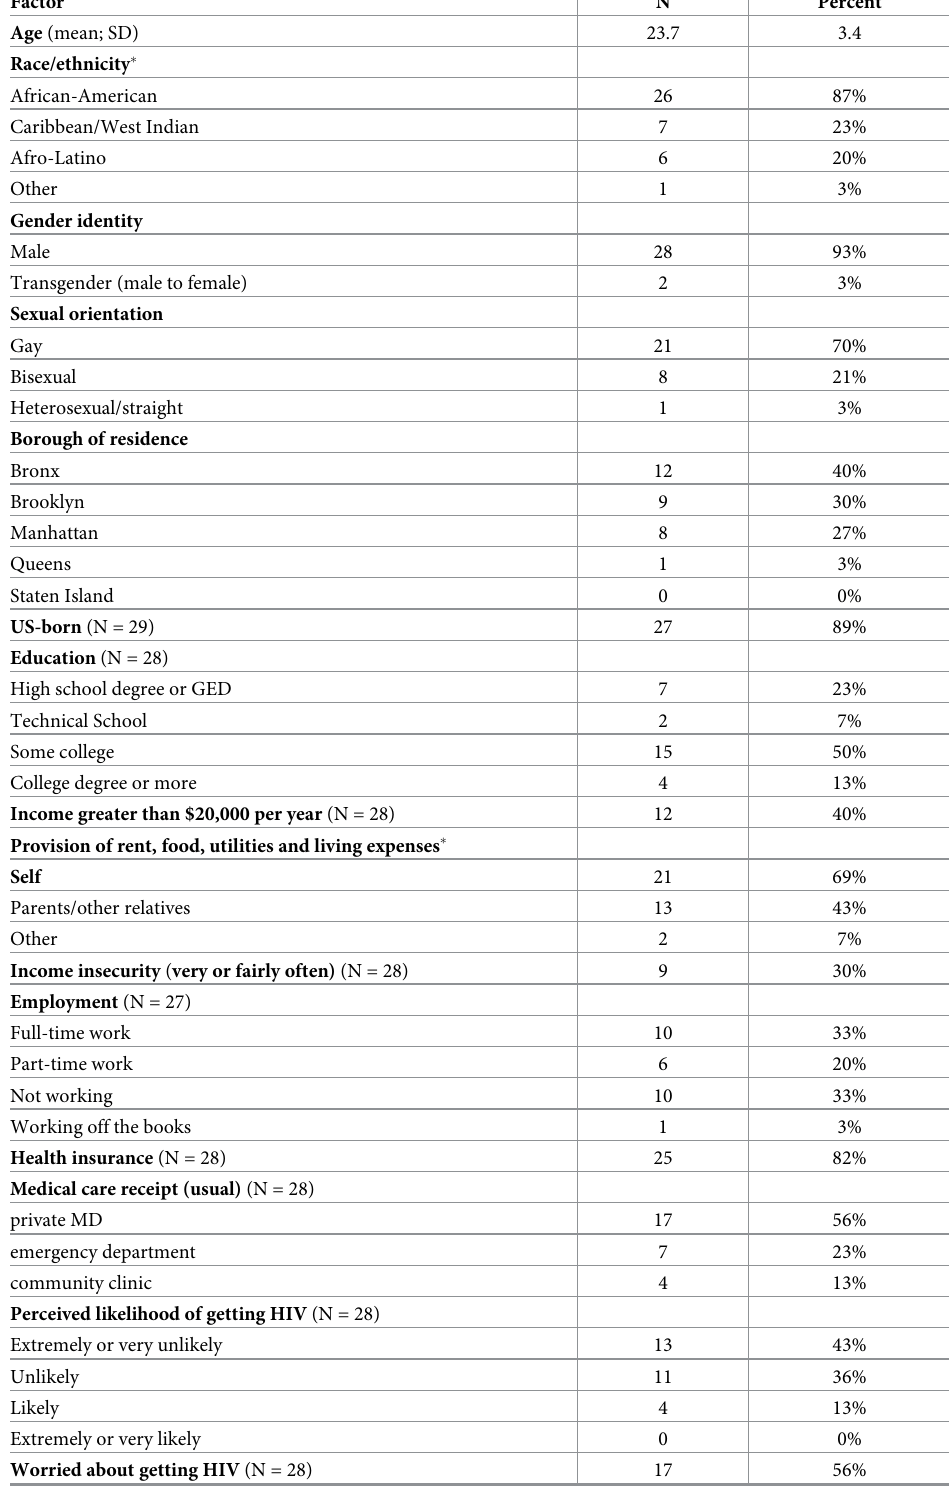
Table 1. Sociodemographic, health, HIV risk perception, and HIV testing characteristics of sample (N = 30 ‡